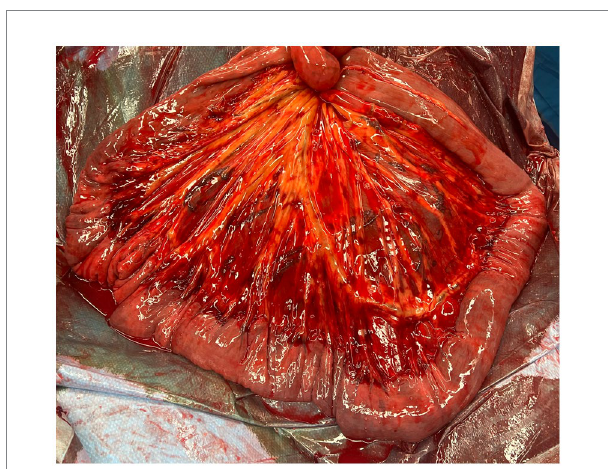
FIGURE 1 Serosal and mesenteric inflammation of the ileum and distal jejunum after manual decompression to resolve an ileal